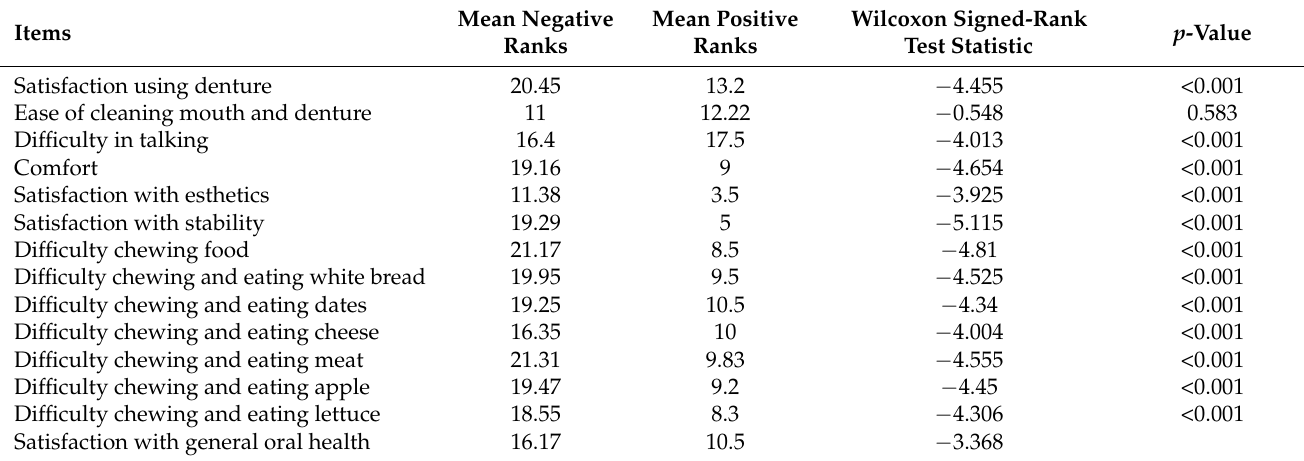
Table 3. Comparison of mean ranks of satisfaction level responses between conventional dentures